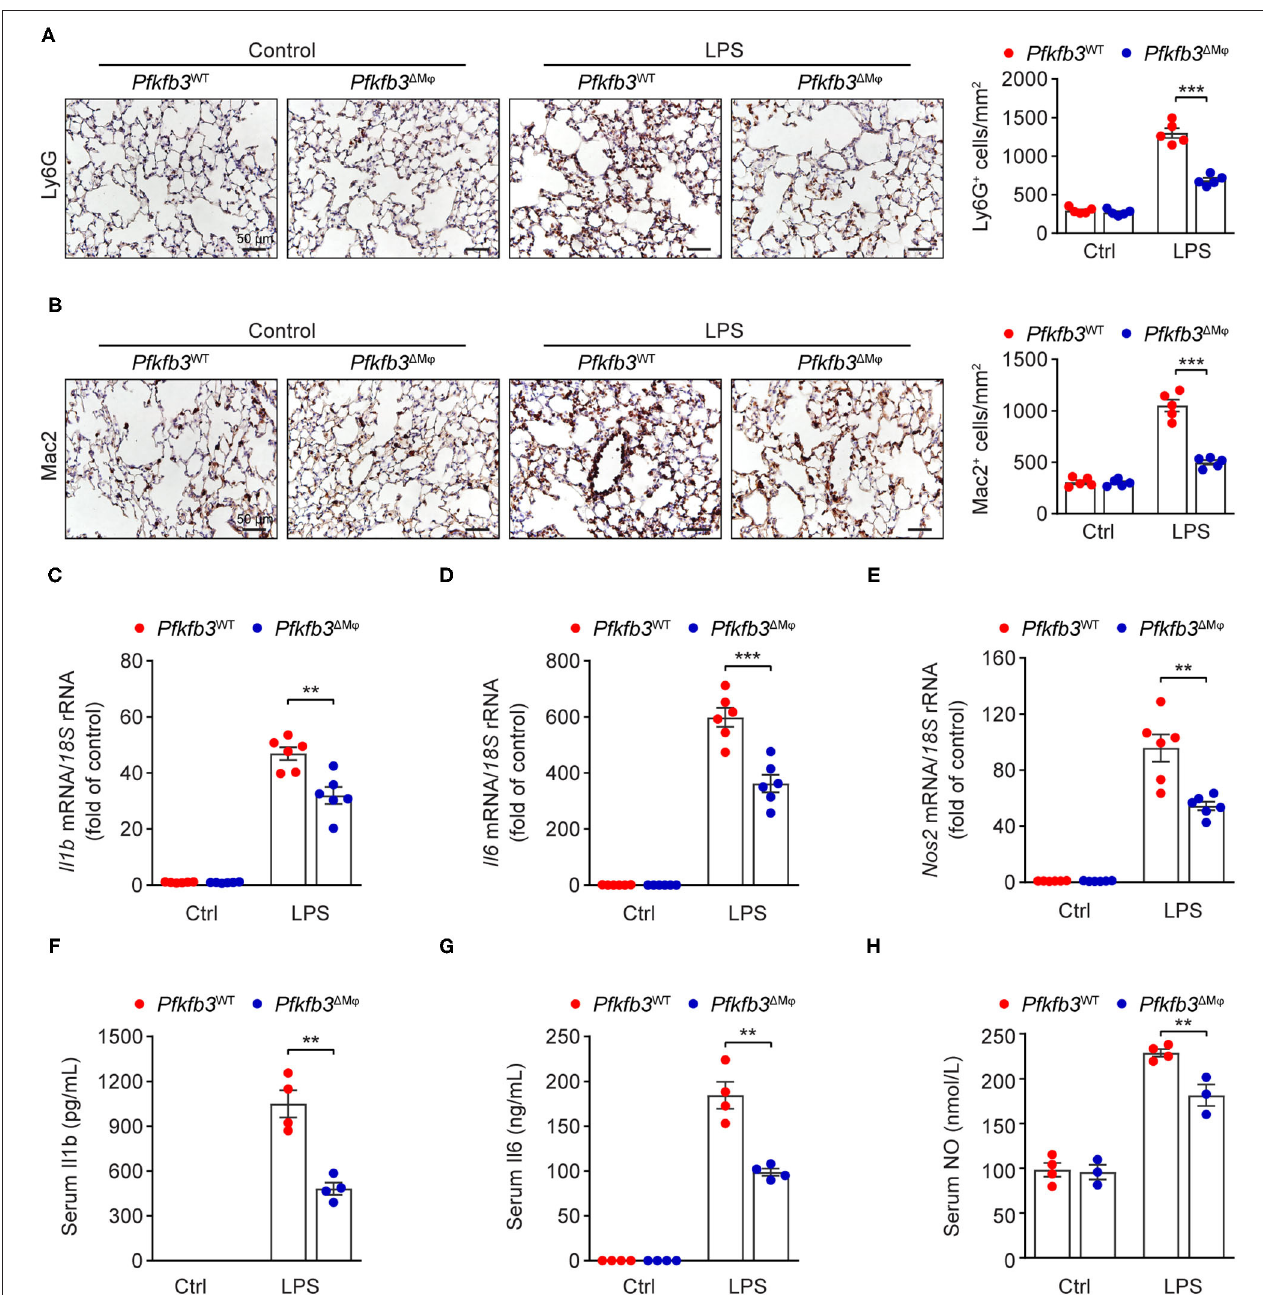
FIGURE 5 | Myeloid-specific Pfkfb3 deficiency attenuates LPS-induced inflammatory responses. (A) Representative images (left) and quantification (right) for immunohistochemical staining of the neutrophil marker Ly6G in lung sections of Pfkfb3 WT mice and Pfkfb3 1 M φ mice 6h after LPS injection ( n = 5). (B) Representative images (left) and quantification (right) for immunohistochemical staining of the macrophage marker Mac2 in lung sections of Pfkfb3 WT mice and Pfkfb3 1 M φ mice 6h after LPS injection ( n = 5). (C–E) qPCR analysis of the mRNA levels of Il1b (C) , Il6 (D) and Nos2 (E) in the lung of Pfkfb3 WT mice and Pfkfb3 1 M φ mice 6h after LPS injection ( n = 6). (F,G) ELISA analysis of Il1b (F) and Il6 (G) in serum of Pfkfb3 WT mice and Pfkfb3 1 M φ mice 6h after LPS injection ( n = 4). (H) NO levels in serum of Pfkfb3 WT mice and Pfkfb3 1 M φ mice 6h after LPS injection ( n = 3–4). All data are represented as mean ± SEM, ** P < 0.01 and *** P < 0.001 for Pfkfb3 WT vs. Pfkfb3 1 M φ (unpaired two-tailed Student’s t